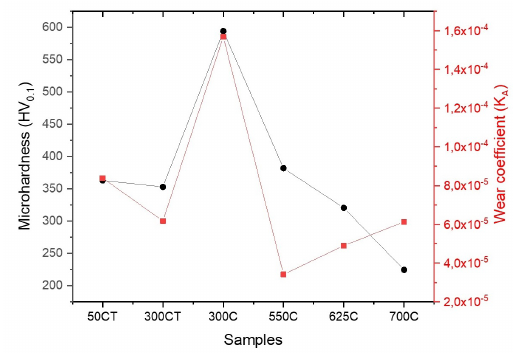
Figure 6. Microhardness and wear coefficient of